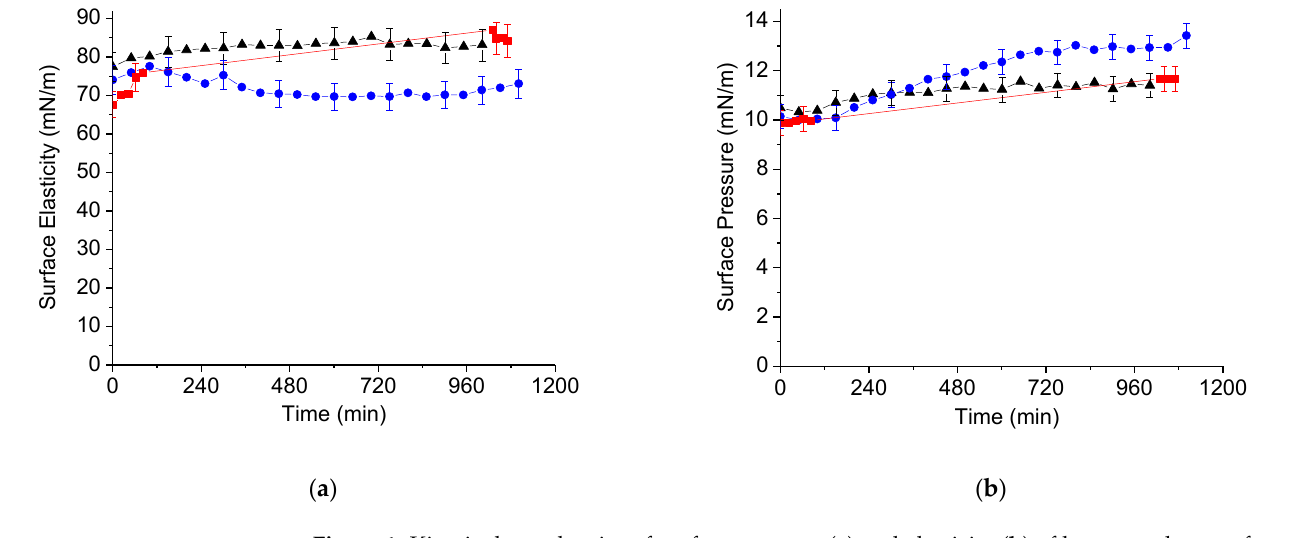
Figure 1. Kinetic dependencies of surface pressure ( a ) and elasticity ( b ) of lysozyme layers after a DNA injection into the subphase. The total DNA concentration is 14 μM , and the initial surface pressure is 10 mN/m. The three sets of experimental data correspond to different independent measurements. Lines are guides for the eye.